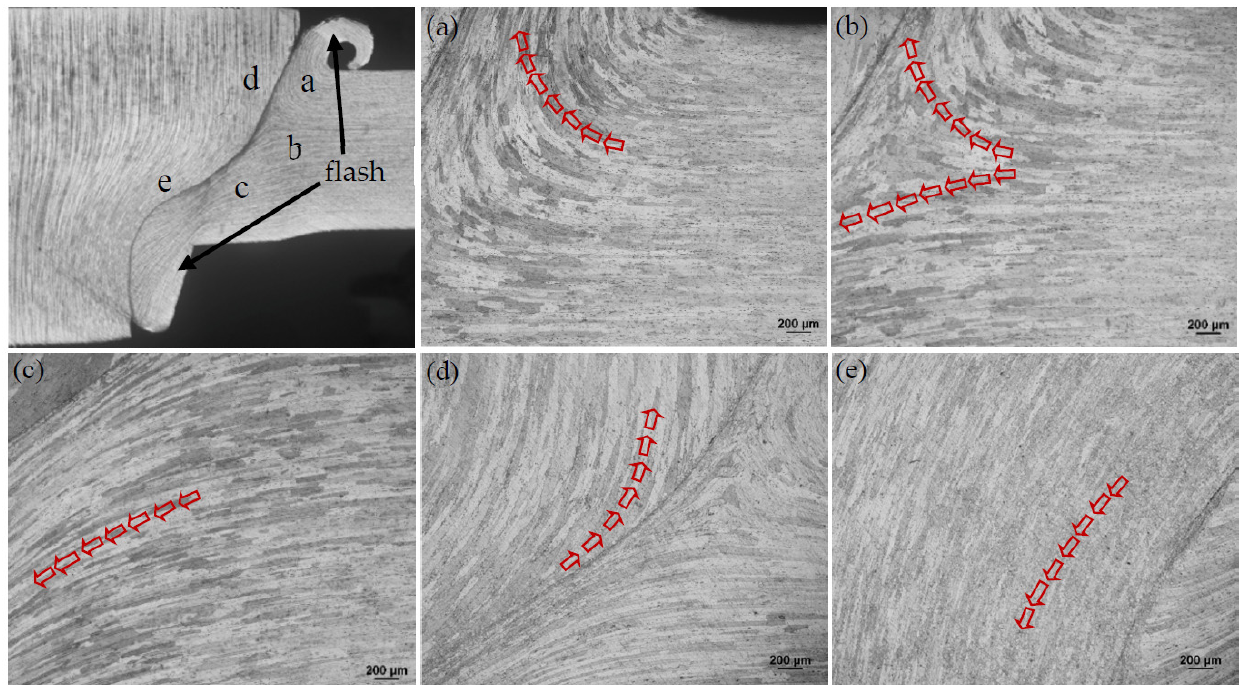
Figure 10. Material flow direction of FPW joint along the perpendicular direction of FSW: ( a ) top of the base metal, ( b ) middle of the base metal, ( c ) bottom of the base metal, ( d ) top of the plug and ( e ) bottom of the plug.